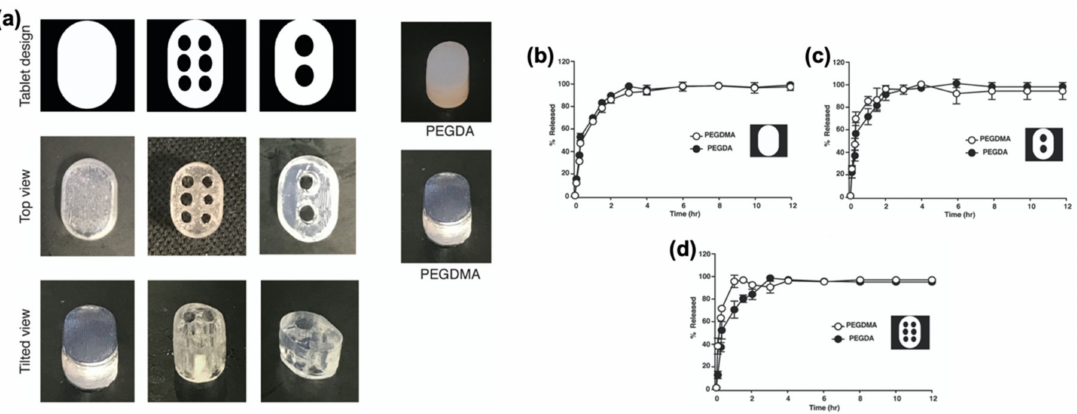
Figure 7. ( a ) DLP-printed theophylline tablets with PEG (polyethlylene glycol) and dimethacrylate (PEGDMA) with different geometries; drug release profiles from tablets with ( b ) no holes; ( c ) two holes; ( d ) six holes. Adapted with permission from Reference [105]. Copyright 2019, Elsevier.